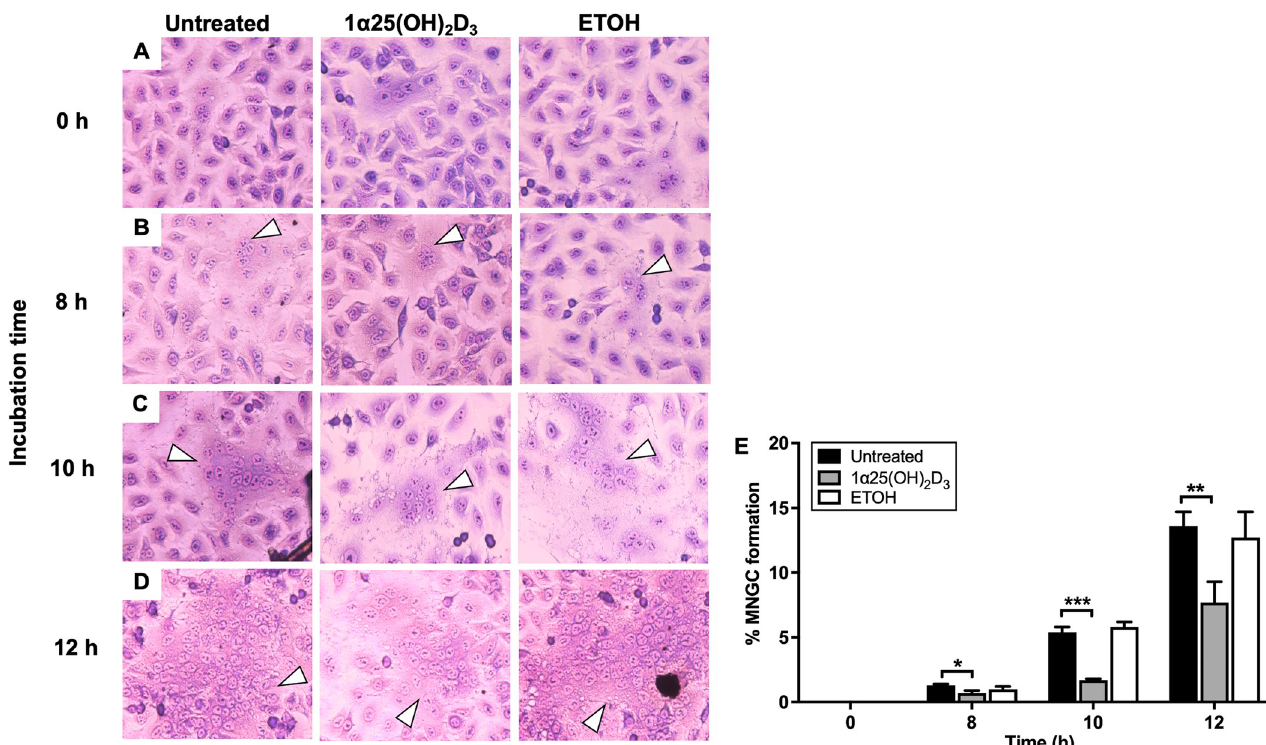
Fig 5. MNGC formation is lower in 1 α ,25(OH) 2 D 3 -pretreated A549 cells during B . pseudomallei infection. Untreated, 1 α ,25(OH) 2 D 3 -pretreated and ETOH-pretreated A549 cells were infected with B . pseudomallei . MNGC formation in each condition was determined at 0 (A), 8 (B), 10 (C) and 12 h (D) and expressed as percentages (E). The white arrows indicate the formation of MNGCs. The results are shown as mean ± SD from three independent experiments carried out in triplicate. � P < 0.05, �� P < 0.01 and ��� P < 0.001.